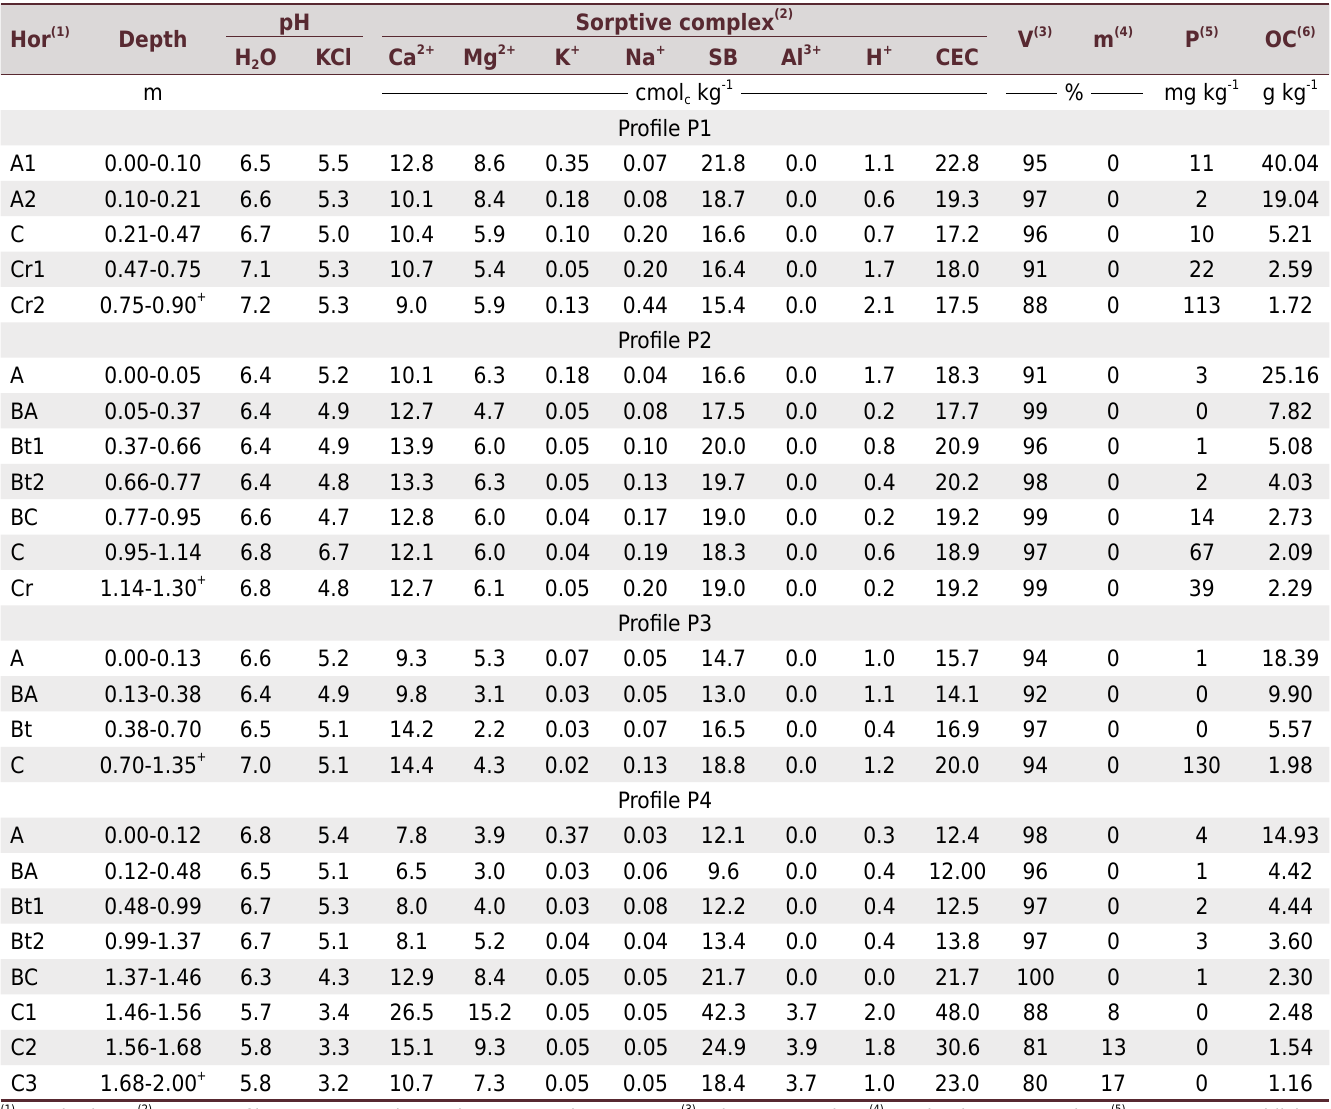
Table 3. Chemical attributes of soil profiles in a toposequence in Pinheiral, RJ Hor (1)